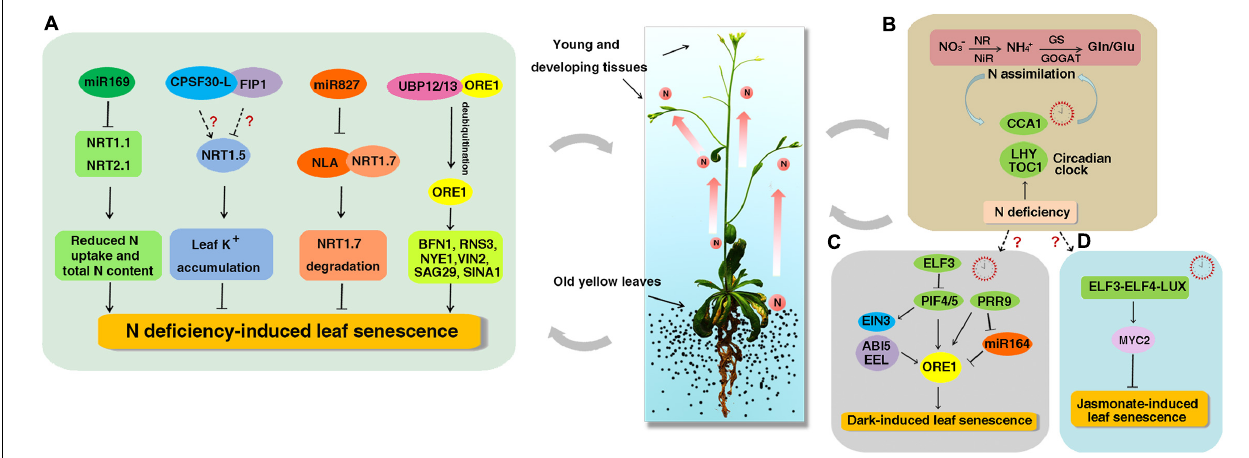
FIGURE 1 | The working model of NO 3 − regulation on leaf senescence and circadian clock. Leaf senescence accompany with N reallocation to meet the demand of N in young and developing tissues. (A) The miR169 reduces the N uptake and total N content by decreasing the expression of NRT1.1 and NRT2.1 and promotes the early senescence induced by N starvation. NRT1.5 increases foliar K + levels to suppress NO 3 − starvation-induced leaf senescence. CPSF30-L interacts with FIP1 and both can regulate the expression of NRT1.5 , but if both genes participate in NO 3 − starvation-induced leaf senescence remains unknown. As a target of miR827, NLA directly interacts with NRT1.7 and promotes its degradation to repress leaf senescence. UBP12 and UBP13 interact with ORE1 and promote its deubiquitination to prevent ORE1 from degradation. The increased ORE1 levels activate the expression of downstream SAGs such as BFN1 , RNS3 , NYE1 , VNI2 , SAG29, and SINA1 to promote N deficiency-induced leaf senescence. (B) A feedback loop between N assimilation and circadian clock. Organic N influences the CCA1 phase and CCA1 in turn regulates the expression of organic N-regulated genes. N deficiency condition can increase the amplitudes of CCA1 , LHY , and TOC1 transcripts. (C) ELF3 inhibits the expression of PIF4/PIF5 to repress dark-induced leaf senescence. PIF4 and PIF5 promote dark-induced senescence by directly activating the expression of ORE1 and indirectly activating the expression of EIN3, ABI5, and EEL . PRR9 can activate the expression of ORE1 directly or suppress the expression of miR164 to promote dark-induced leaf senescence. (D) The circadian evening complex (ELF3-ELF4-LUX) directly binds to the promoter of MYC2 to repress jasmonate-induced leaf senescence. However, if circadian clock is involved in N deficiency-induced senescence remains unknown. The solid and dotted arrows represent known and unknown functions,